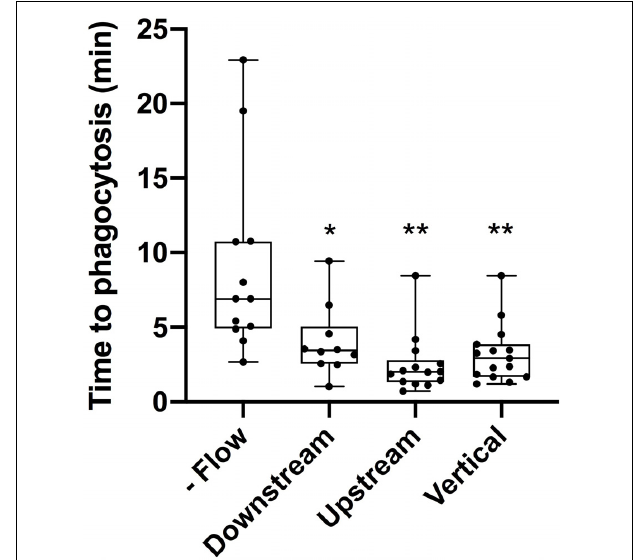
FIGURE 3 | Cells under flow conditions initiated phagocytosis at a significantly faster rate than cells under static conditions. “No flow” cells under static conditions initiated phagocytosis on average 9 min post-photolysis. This was significantly longer ( p = 0.028, denoted with 1 asterisk) than the average initiation time for downstream cells initiating phagocytosis on average 4 min post-lysis. Similarly, upstream cells with an average initiation time of 2.5 min and vertical cells with an average initiation time of 3.2 min both were significantly faster than no flow cells with p < 0.01 (denoted by 2